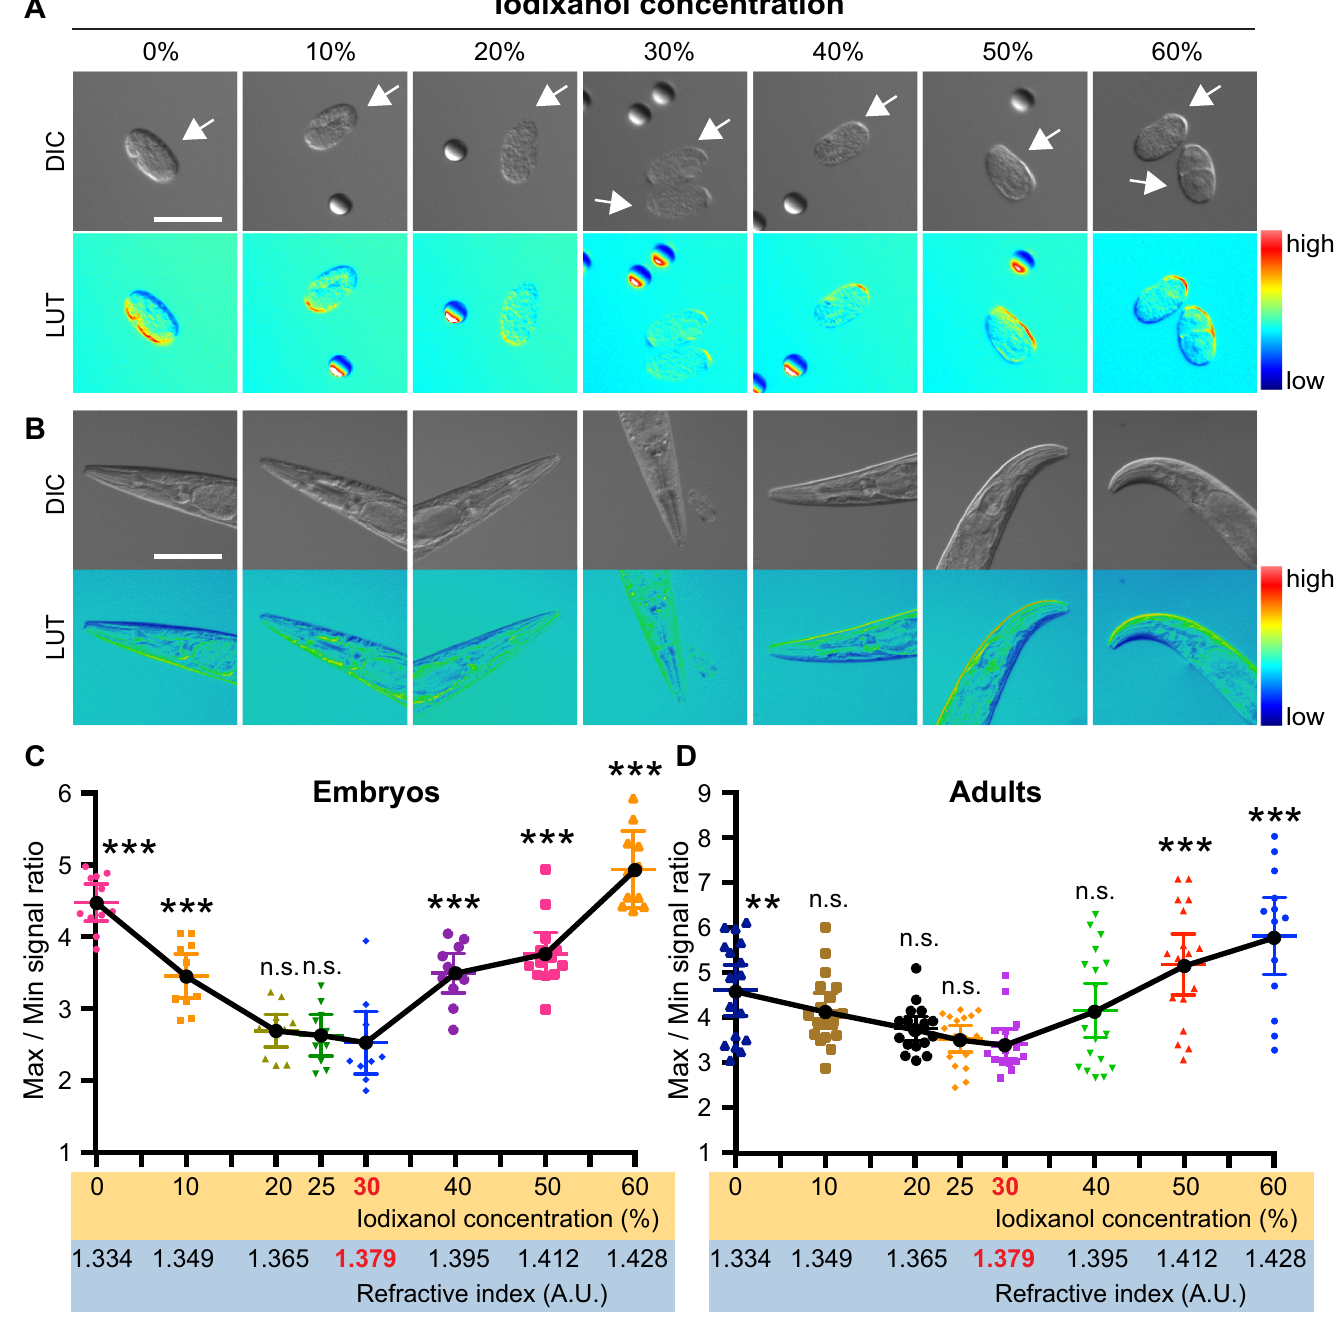
Fig 1. Determination of a refractive index matching medium for live C . elegans . (A, B) C . elegans embryos (A) and adult heads (B) imaged at different iodixanol concentrations. Images were obtained by Nomarski DIC microscopy. LUT images are intensity-based pseudocolored DIC images (pseudocolor was applied using the look-up table called “physics”). Arrows indicate embryos. Note that the spheres in some images are polystyrene beads used as a reference (see Materials and methods). (C, D) The extent of image contrast was calculated by dividing the maximum signal intensity in the sample area by that of the minimum. As both curves show that the average image contrast is the lowest at 30% iodixanol, statistical tests were performed by comparing samples treated with 30% iodixanol and others. P-values were calculated by one-way ANOVA with the Holm-Sidak’s multiple comparison test. n.s. (P > 0.05), �� (P < 0.001), and ��� (P < 0.0001). Scale bars, 50 μ